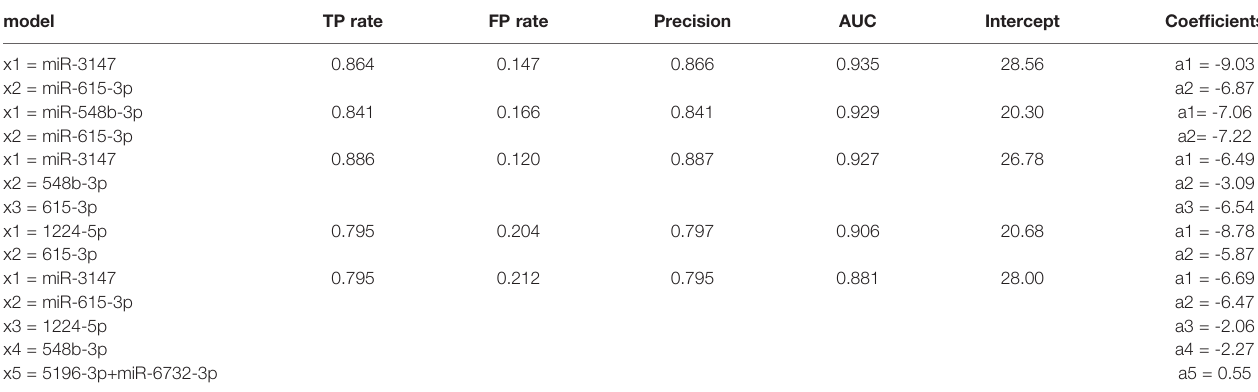
TABLE 3 | Summary of the basic parameters and common quality measures of the models. model TP rate FP rate Precision AUC x1 = miR-3147